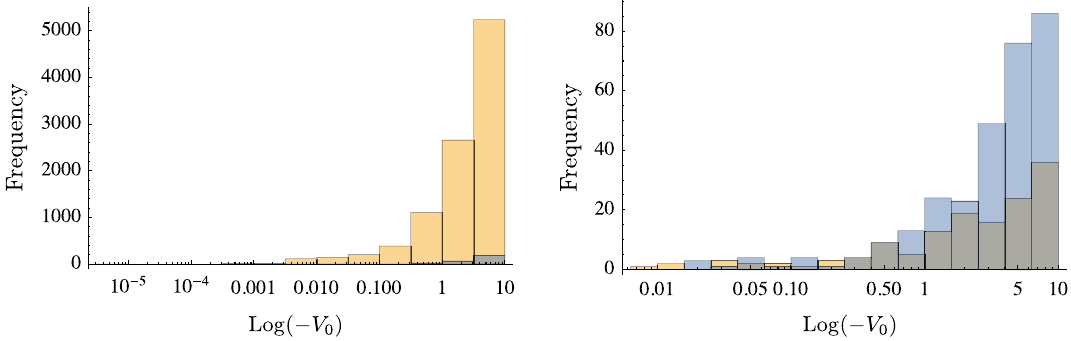
criterion II. This data represents the first step in the training of the ANN and corresponds only to the free tachyon vacua